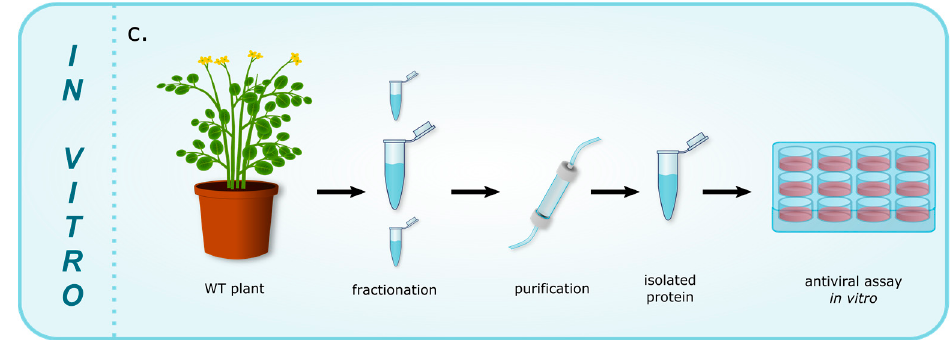
Figure 1. Schematic depiction of different strategies for studying antiviral protein properties. ( a ) Gene knockout technology employing loss-of-function mutant plants generated by performing genetic manipulations inactivating appropriate gene of interest (GOI); ( b ) genetically modified (GM) plants produced by the means of genetic transformation overexpressing particular protein of interest. After several days post-inoculation plants from both section ( a , b ) were compared with appropriate controls and analyzed using different bioassays (e.g., enzyme-linked immunosorbent assay (ELISA), quantitative polymerase chain reaction (qPCR), immunoblotting etc.); ( c ) isolation of a protein of interest using different fractionation and purification methods (e.g., ammonium sulfate precipitation, cation-exchange chromatography, etc.). Antiviral activity of isolated proteins was then assayed in vitro. In several studies more than one method for investigating protein antiviral activity was performed. The methods shown and described above are simplified for easier understanding of the main concept.